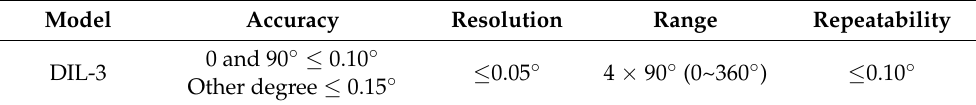
Table 3. Technical parameters of magnetic suction digital protractor.